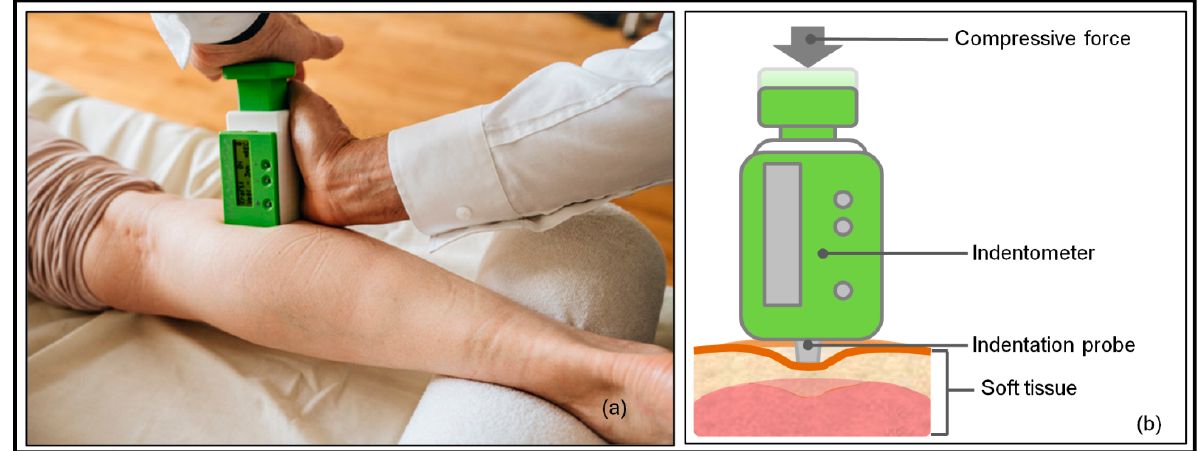
Figure 2. Myofascial tissue stiffness measurement with the IndentoPro. ( a ) Placement of the in- dentometer; ( b ) drawing of the stiffness measurement: after compressive force application, the indentation probe comes out of the indentometer body, indenting the soft tissue. The applied force (Newton) and resulting indentation depth (mm) are shown on a display.